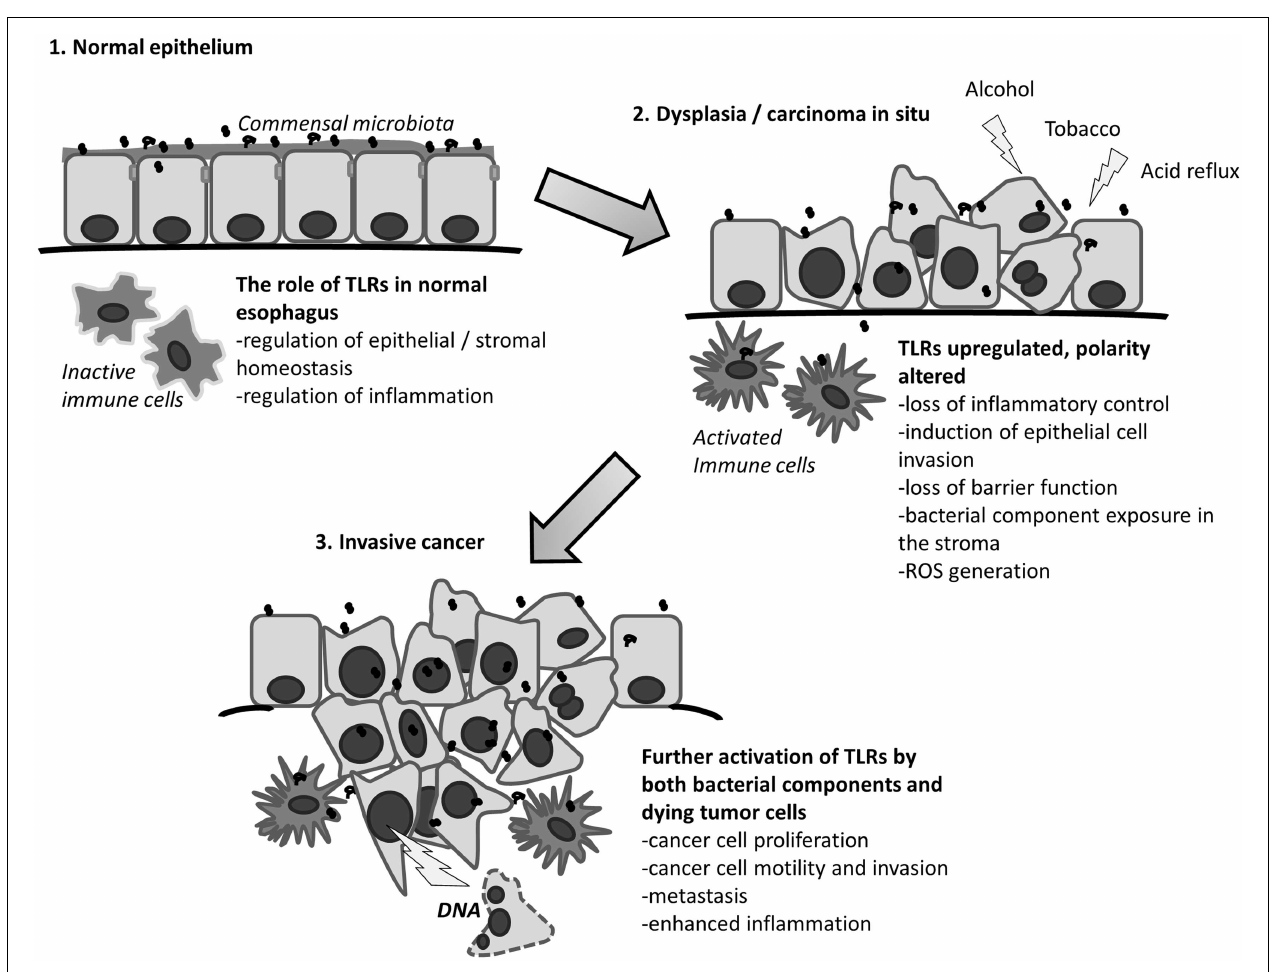
FIGURE 1 |The proposed role ofToll-like receptors in esophageal cancer . Modified from Kauppila et al.